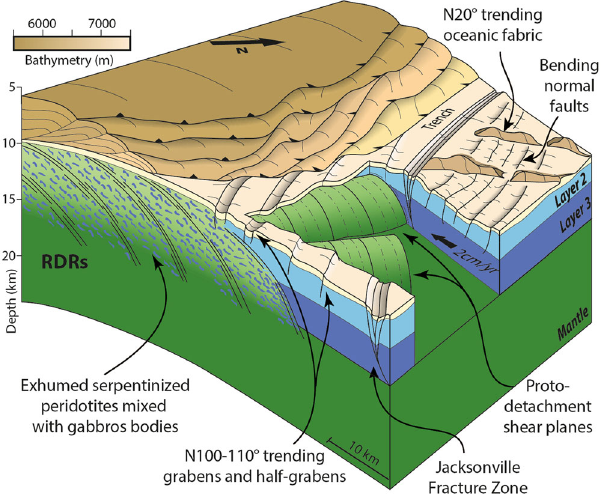
Fig. 4 Interpreted 3D view of the tectonically dominated slow-spreading basement subducting beneath the Northern Lesser Antilles Subduction Zone. Perspective view showing the structural transition of the Atlantic basement from the inside to the outside corner of the Jacksonville Fracture Zone. The Jacksonville patch at the inside corner consists of serpentinized mantle rock possibly mixed with gabbro bodies exhumed along proto- detachment shear planes which formed at a tectonically dominated magma poor ridge segment end. These detachments, reactivated while subducting beneath the NLA draw Ridgward Dipping Re fl ectors (RDRs) in along-dip vertical